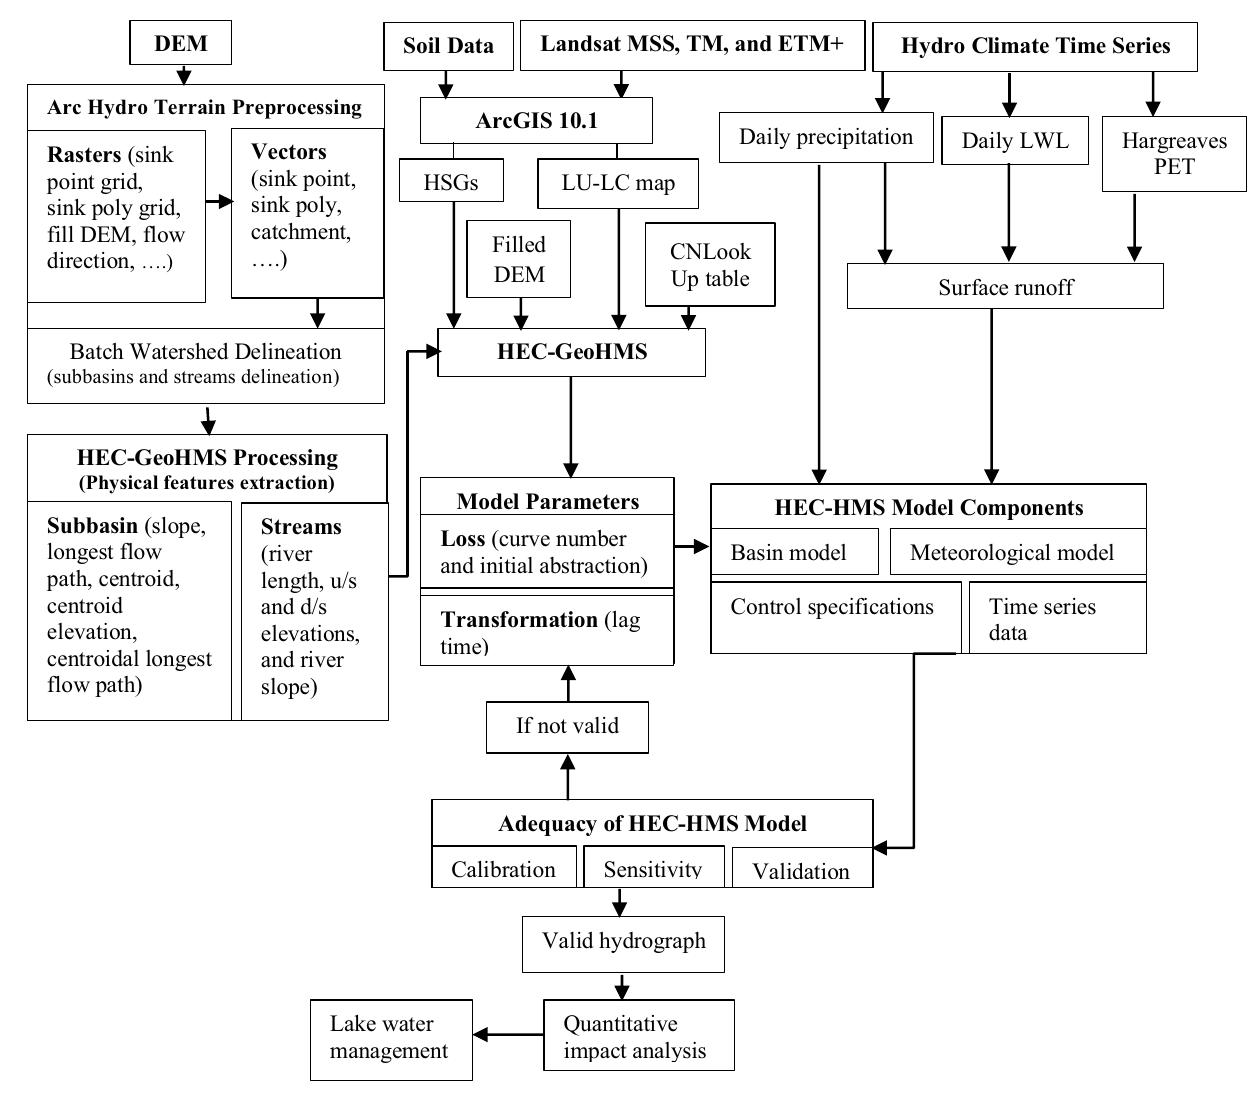
Fig. 2 Conceptual framework of the research